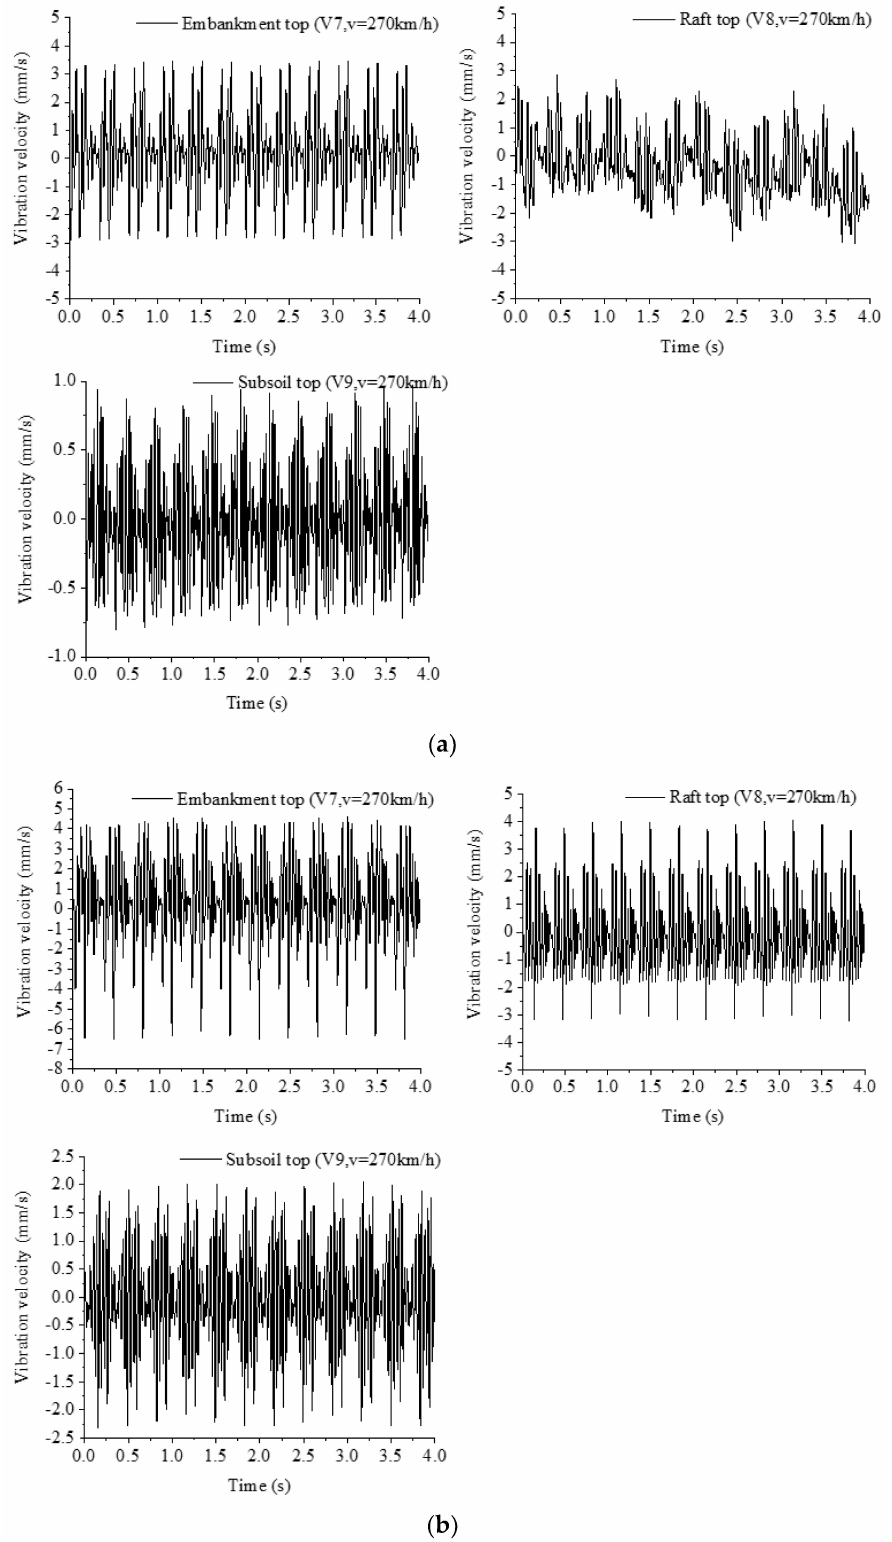
Figure 10. Time histories of vibration velocities at embankment top V7, raft top V8, and subsoil top V9. ( a ) Low water level v = 270 km/h, ( b ) High water level, v = 270